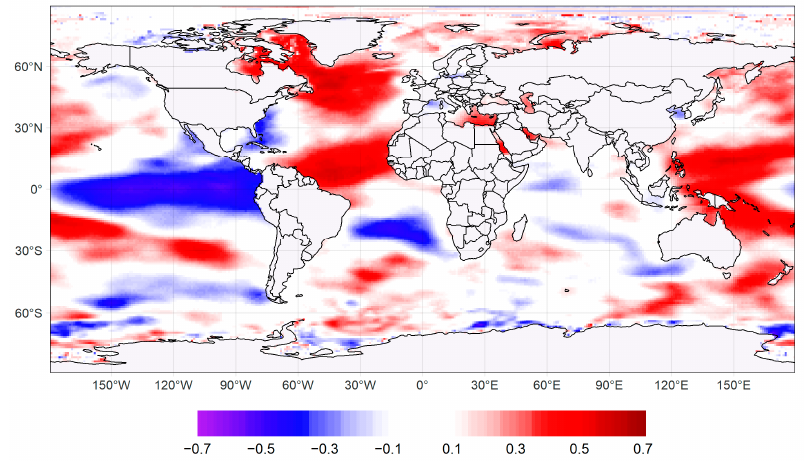
Figure 5. Spatial distribution of the correlation coefficient between the annual number of TCs and the annual average SST.